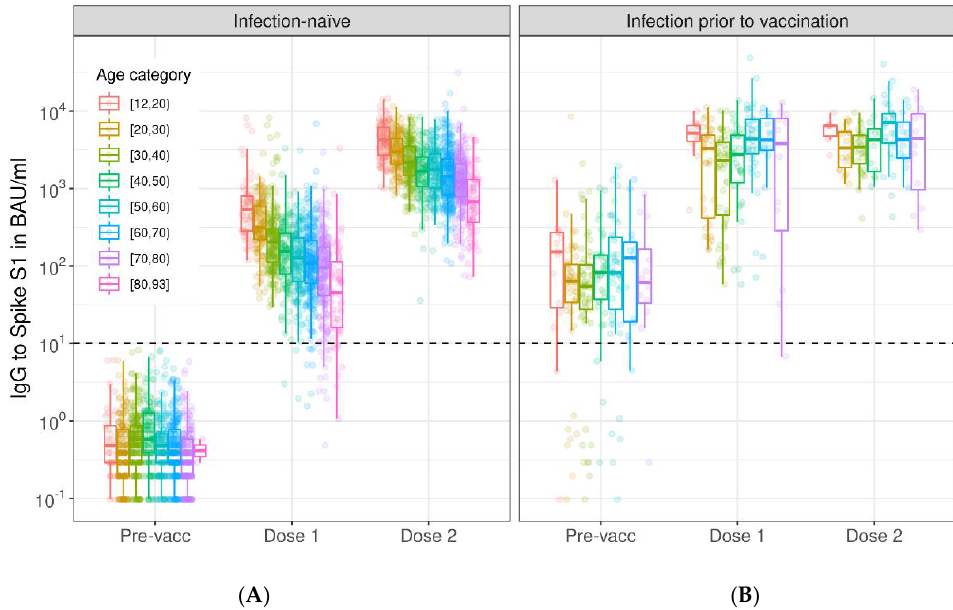
Figure 2. Spike S1-specific IgG kinetics by age category following the primary series of BNT162b2 vaccination in infection-naive participants ( A ) and participants with a SARS-CoV-2 infection prior to vaccination ( B ). Boxplots show results by age group at each time point, while dots show individual measurements. Results are shown for total of 1500 infection-naive participants and 235 participants with a SARS-CoV-2 infection history; measurements were not available at every time point for each participant (see Supplementary Table S2). Spike S1 IgG concentrations were expressed in international binding antibody units (BAU) using the 20/136 NIBSC standard and were taken prior to vaccination (Pre-vacc), one month following the first (Dose 1), and one month following the second vaccination dose (Dose 2). The horizontal dashed line represents the threshold for seropositivity to Spike S1. IgG: immunoglobulin G; BAU: binding antibody units. Table 1. Linear mixed effects regression results for Spike S1 IgG concentrations up to one month following two doses of BNT162b2 for infection-naive persons. Model results for 1448 unique partici- pants with S1 IgG measurements available at one month after the first (Dose 1) or second vaccination dose (Dose 2). Three persons reporting their sex as “other” were excluded from the